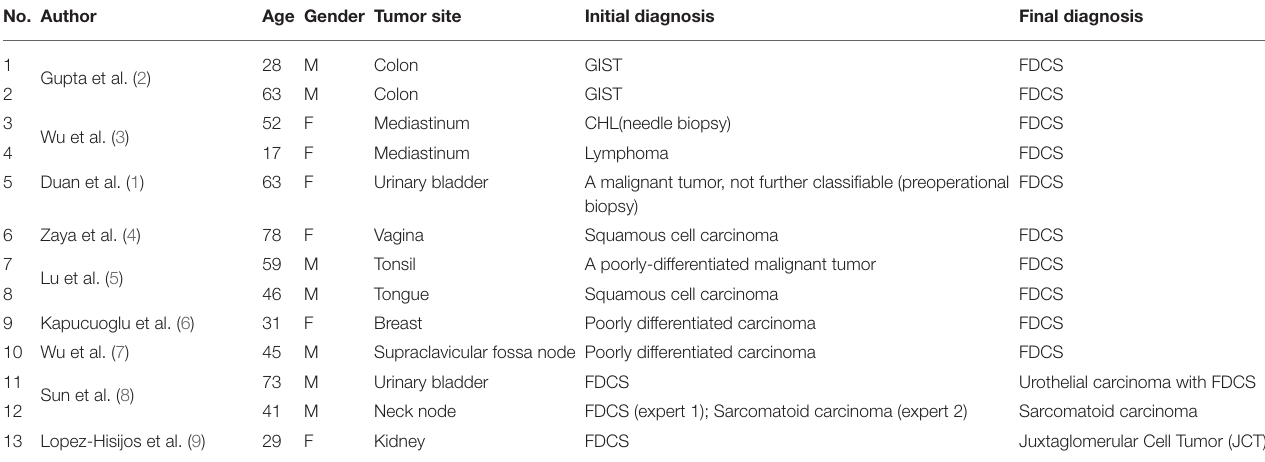
TABLE 1 | Information of 13 misdiagnosed FDCS cases retrieved from PubMed between 2009 and